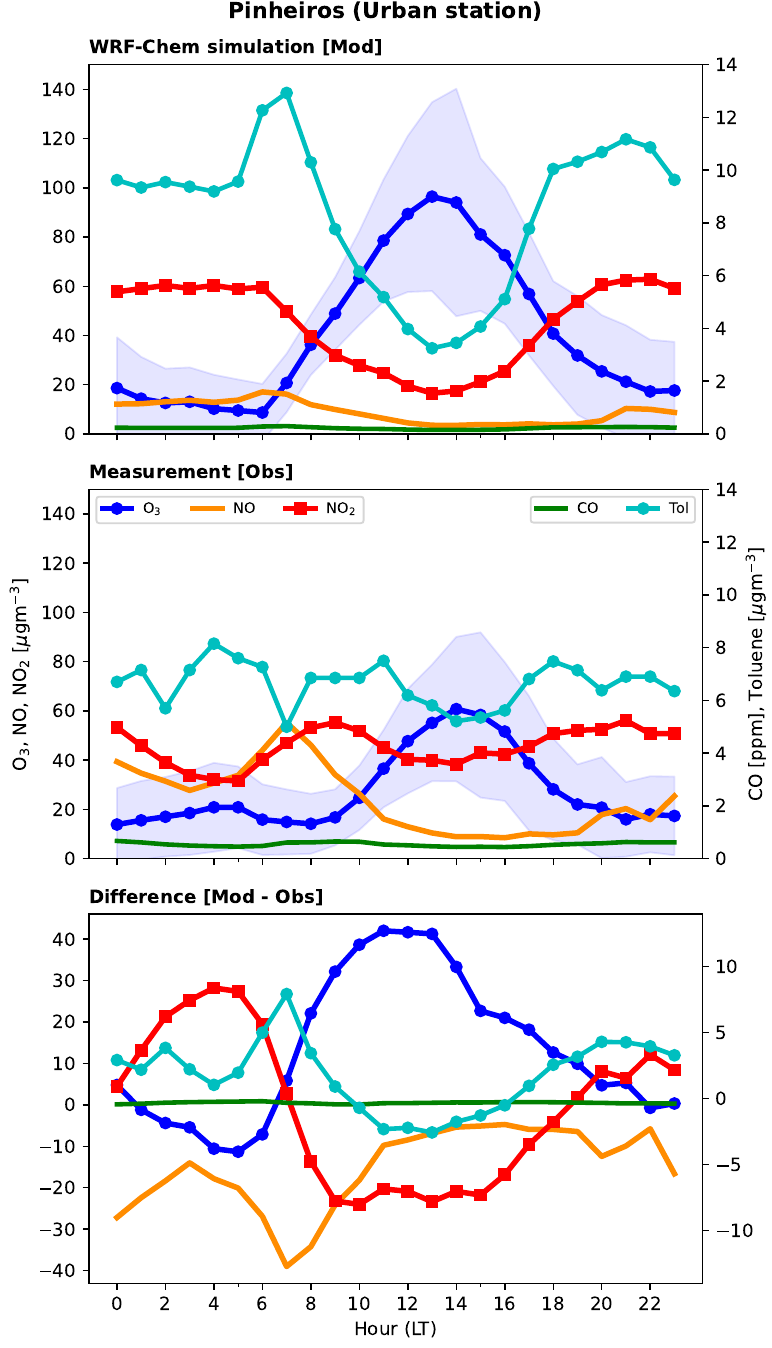
Figure 4. Modeled compared with observations and their differences as mean diurnal profiles of air pollutant concentrations for Pinheiros urban station for two months (September and October 2018). The standard deviation is in a blue-shaded area, calculated from hourly data for simulations (Mod) and observations